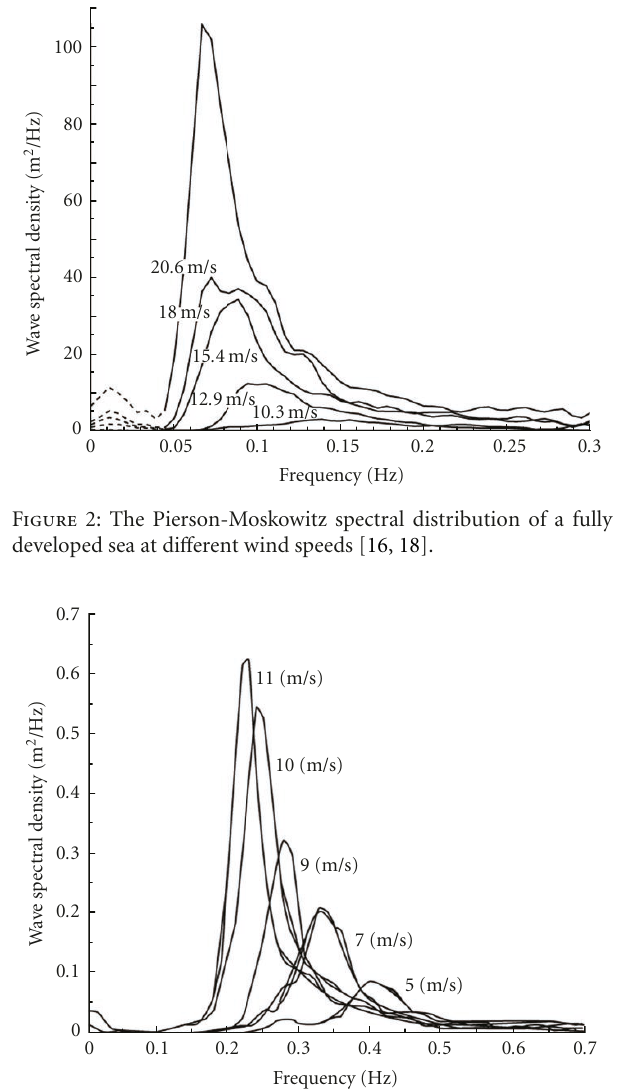
Figure 3: The JONSWAP spectral distribution of a fully developed sea at di ff erent wind speeds [17, 18].